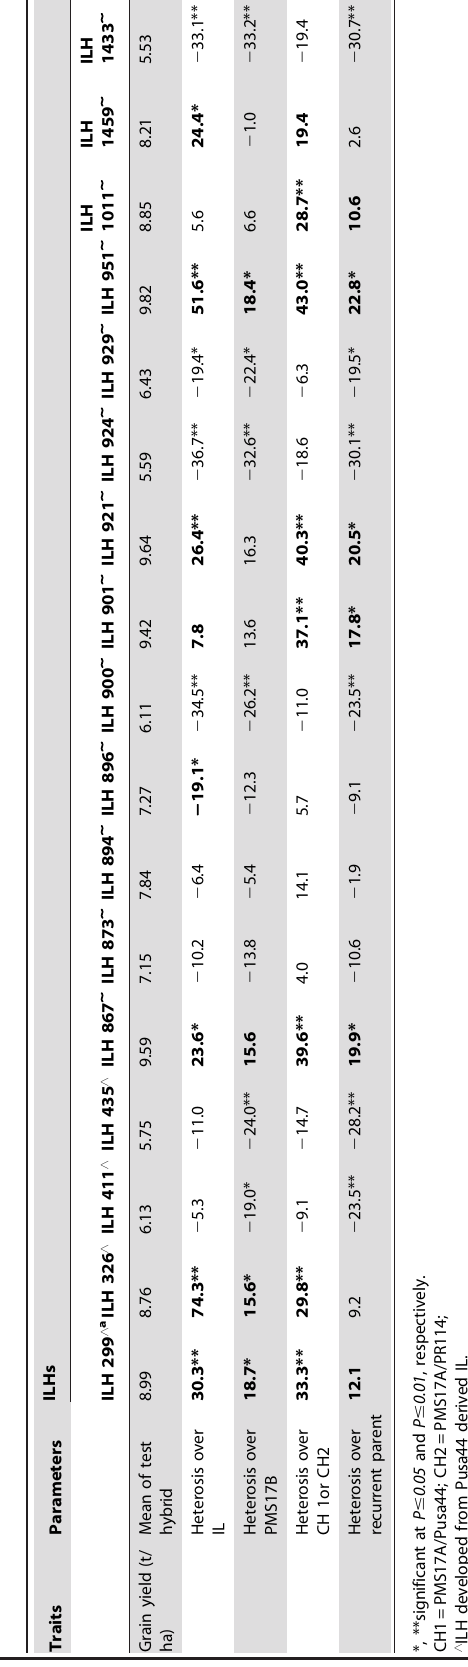
IL326, respectively. Both the introgression lines had common introgression at marker loci RM508 (0.0 cM) on chromosome 6, RM407 (5.7 cM) on chromosome 8, RM202 (54.0 cM) to RM21 (85.0 cM) on chromosome 11 and RM19 (20.9 cM) on chromo- some 12 (Fig. 4; Fig. S2). These introgression lines showed introgression of O. rufipogon chromatin at RM84, RM220 and RM473A on chromosome 1 and at RM21 on chromosome 11 (Fig. 4). ILH921 recorded higher yield than IL921, PMS17A/ PR114 and parents because of increased panicle length, spikelet fertility, spikelets per panicle and grains per panicle. Molecular characterization of IL921 revealed introgressions of O. nivara chromatin at RM302 (147.8 cM) and RM472 (171.6 cM) on chromosome 1 and RM307 (0.0 cM) and RM401 (8.5 cM) on chromosome 4. ILH951 was the highest yielding among all hybrids because of highest spikelets per panicle, grains per panicle, spikelet fertility and 1000-grain weight. Parental introgression line (IL951) of this hybrid had introgression from O. nivara in seven chromosomes. Introgression was observed for RM109 (4.8 cM) on chromosome 1, RM289 (56.7 cM) on chromosome 5, RM584 (20.2 cM) and RM 351 (73.3 cM) to RM505 (78.6 cM) on chromosome 7, RM38 (28.0 cM) on chromosome 8, RM474 (0.0 cM) to RM222 (11.5 cM) on chromosome 10, and RM206 (102.9 cM) to RM254 (110.0 cM) on chromosome 11 (Fig. 4). The observed improvement in yield-contributing traits in this hybrid could be attributable to introgressions from O. nivara. In addition to yield components, days to 50% flowering and plant height decides the suitability of a hybrid for production. Introgression lines IL867 and IL901 were earlier than recurrent parent PR114, but their hybrids ILH867 and ILH901 took more days to mature than parental introgression lines. O. rufipogon alleles at marker locus RM287 on chromosome 11 in IL867 and IL901 might show increased effect on days to 50% flowering in their